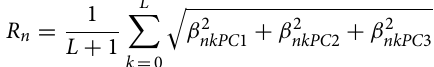
FIGURE 1 | Data processing flowchart. The flowchart showing all data processing steps leading up to the decoding is shown. The left stream corresponds to EEG processing, and the right stream corresponds to kinematics